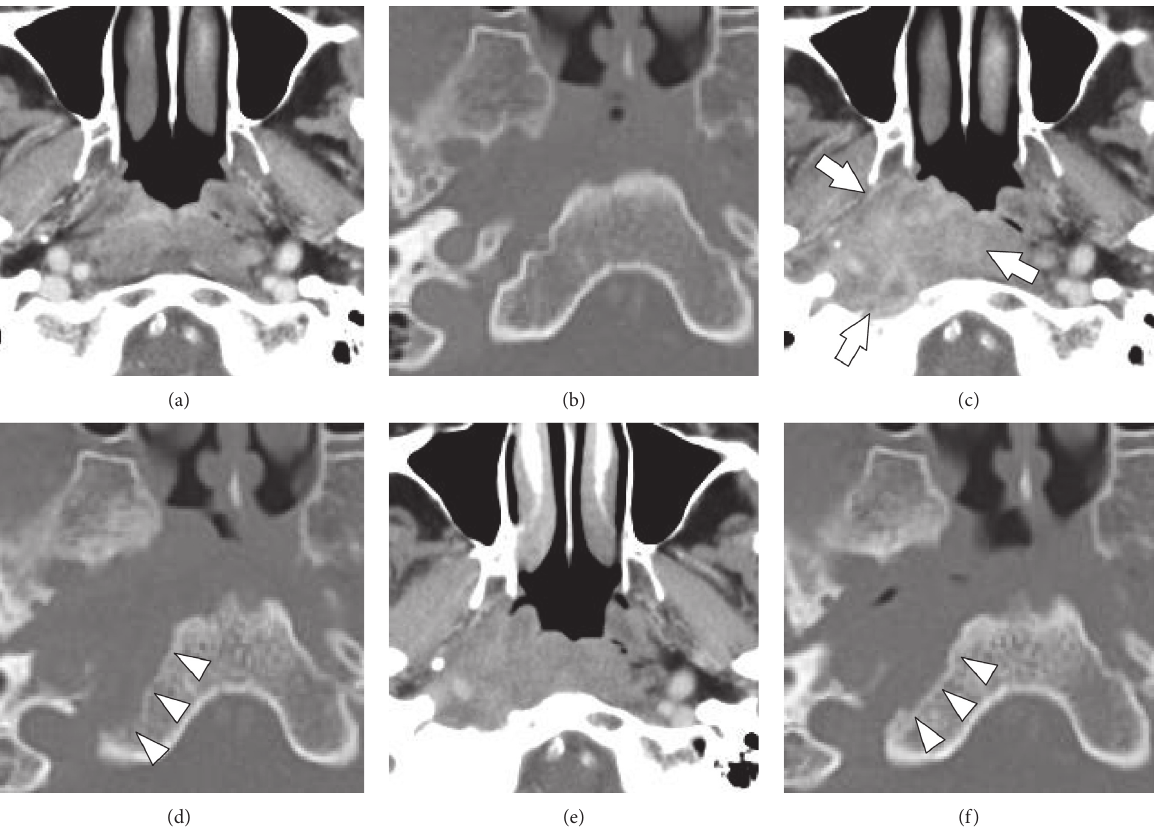
Figure 1: Cervical computed tomography (CT) at the initial visit (a, b) and when glossopharyngeal and vagus nerve paralysis emerged (c, d). CT taken after improvement of symptoms (e, f). The upper panels are contrast-enhanced images of the soft tissue of the nasopharynx (a, c, e). The lower panels are contrast-enhanced images of the bony structure of the extra skull base (b, d, f). The development of diffuse enhancing mucosal irregularity in the nasopharynx (arrow) is shown. (d) The bony erosion of the external skull base (arrow head). (f) The improvement of bony erosion (arrow